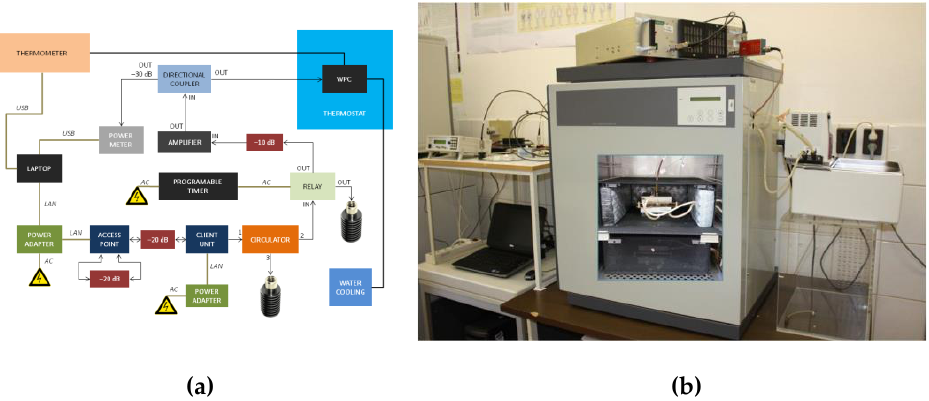
Figure 3. ( a ) Block diagram of a Wi-Fi exposure system; ( b ) arrangement of a whole-exposure